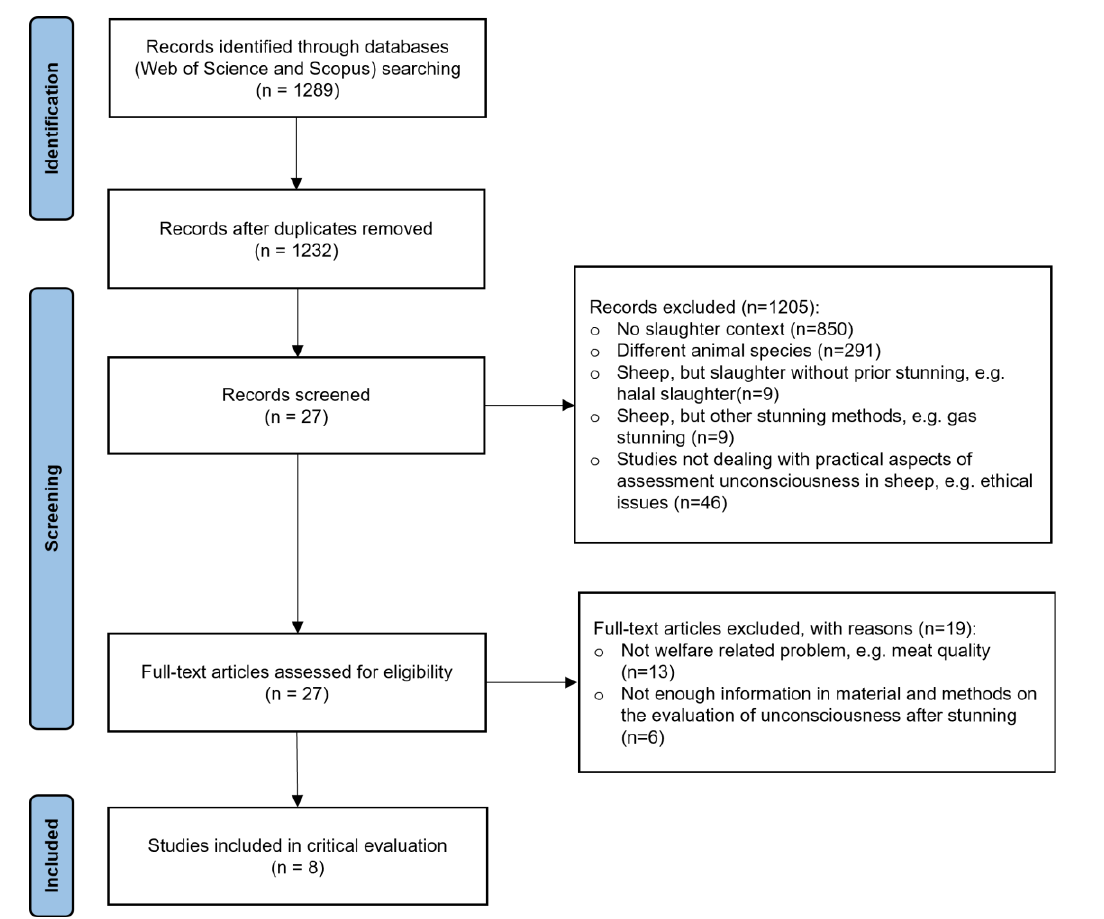
Figure 1. Modified Preferred Reporting Items for systematic Reviews and Meta-Analyses (PRISMA) flow diagram [29] with the review search strategy and study selection.